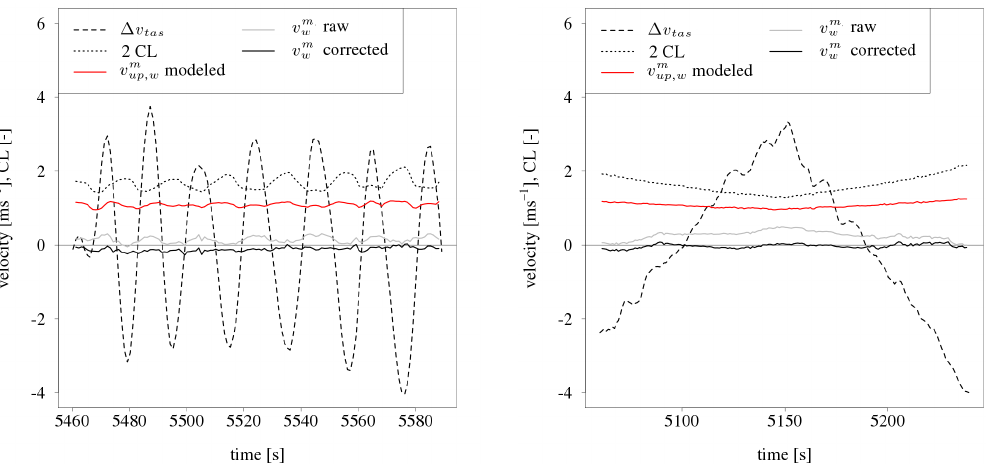
Fig. 8. Forced oscillation pattern (VW3, left) and level acceleration–deceleration pattern (VW1, right) on 25 June 2008. For improved legibility the average is subtracted from true airspeed ( 1v tas ) and lift coefficient is inflated by the factor two (2CL). Displayed is the vertical wind ( v m w ) before (raw) and after (corrected) correction for dependence on the lift coefficient. For comparison the modelled upwash ( v m up ,w ) is presented, which was computed using Eq. (3) and decomposed and rotated from wing- into meteorological coordinates using Eq. (A13).